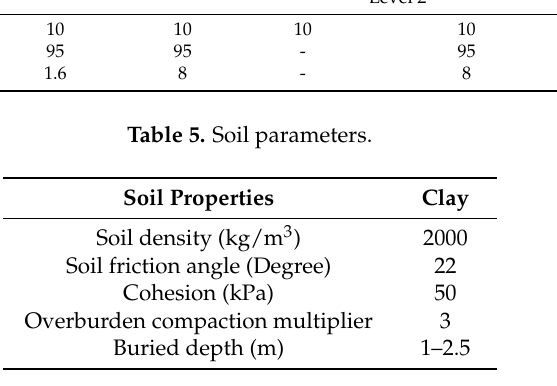
Table 5. Soil parameters.